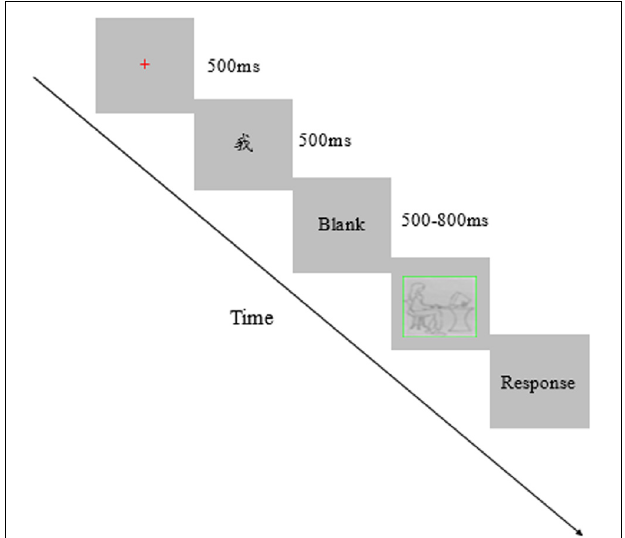
FIGURE 1 | Sequence of events in an experimental